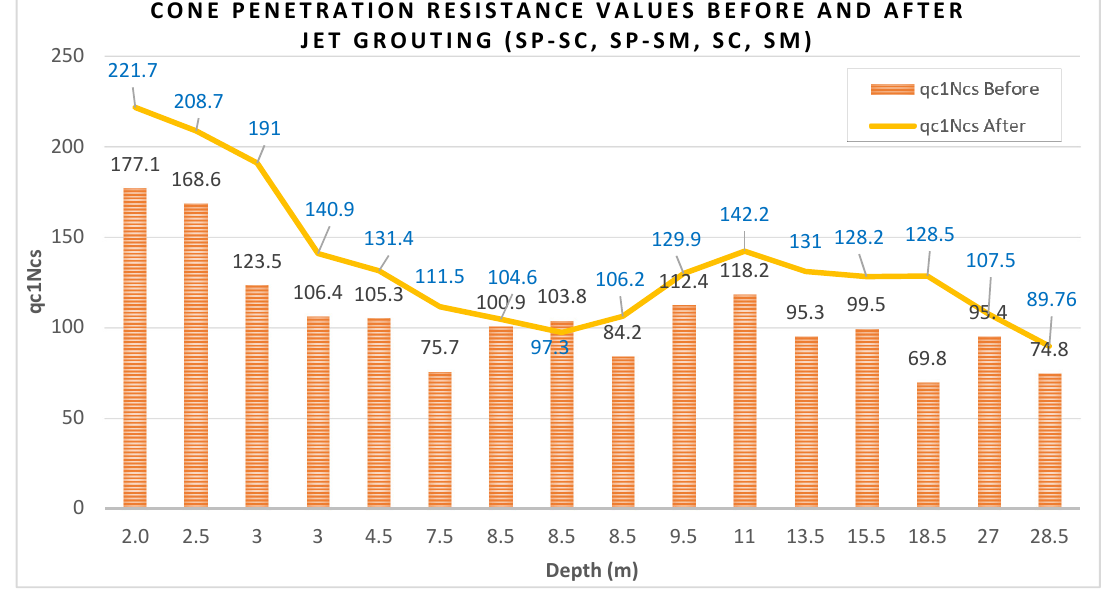
Figure 4. Cone penetration resistance values before and after jet grouting using micropiles in soil profile containing (SP-SC, SP-SM, SC, and SM).